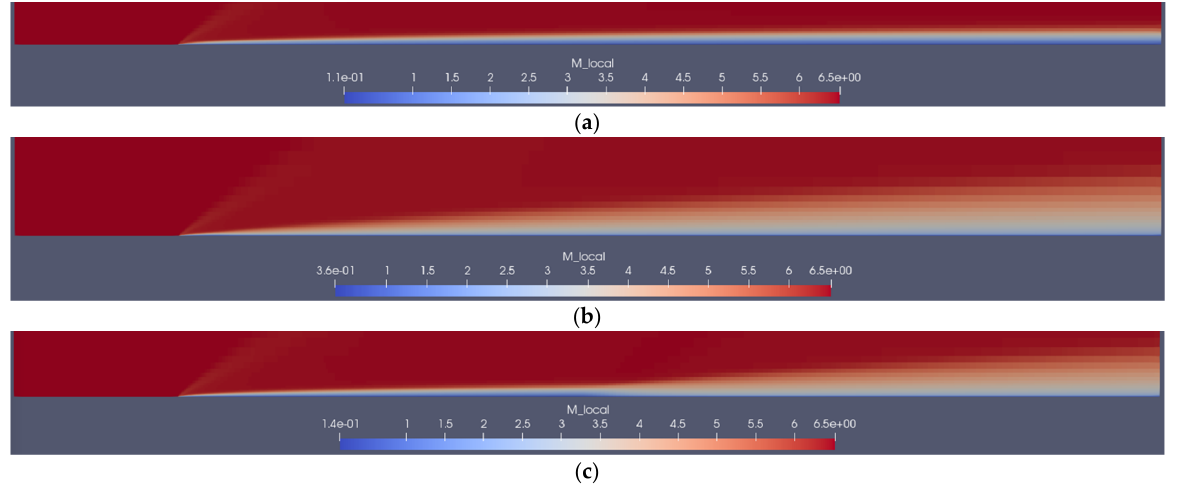
Figure A3. Local Mach number profile of s00: ( a ) laminar model; ( b ) SA model; ( c ) SA-BCM model.